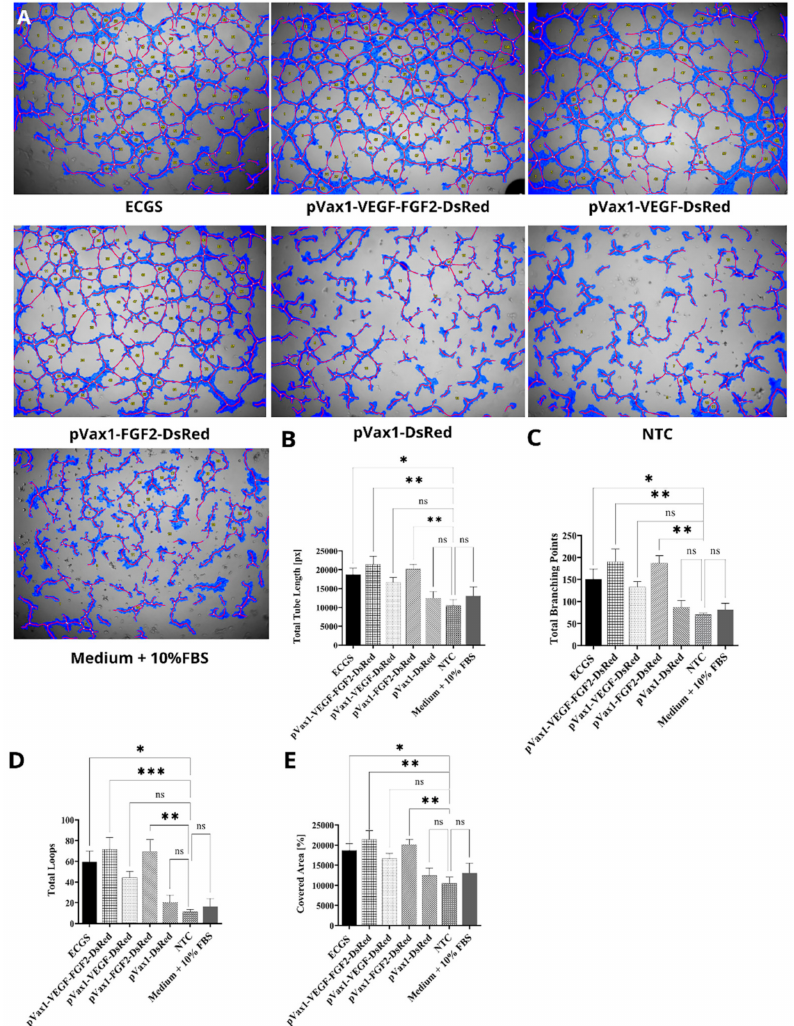
Figure 5. Analysis of tube formation by human umbilical vein endothelial cells (HUVEC). A total of 1 × 10 4 HUVEC were seeded per well in a 96-well plate. HUVECs were cultivated with conditioned media collected from HEK293T cells transfected with pVax1-VEGF-FGF2-DsRed, pVax1-VEGF- DsRed, pVax1-FGF2-DsRed, pVax1-DsRed, and non-transfected control as well (NTC). ECGS— complete medium containing 10% FBS and Endothelial Cell Growth Supplement (30 µ g/mL). Medium+ 10 FBS –medium containing 10% FBS without ECGS. ( A ) Brightfield microscopy im- age, scale bar 200 µ m. ( B ) Length of formed tubes (measured in px), ( C ) Number of branch points formed, ( D ) Number of loops, ( E ) Area of cell coverage. Analysis was carried using Wimasis imaging software package. Data presented as average ± s.e. * indicates statistically significant data relative to control (n = 3; ** p < 0.01; *** p < 0.0001